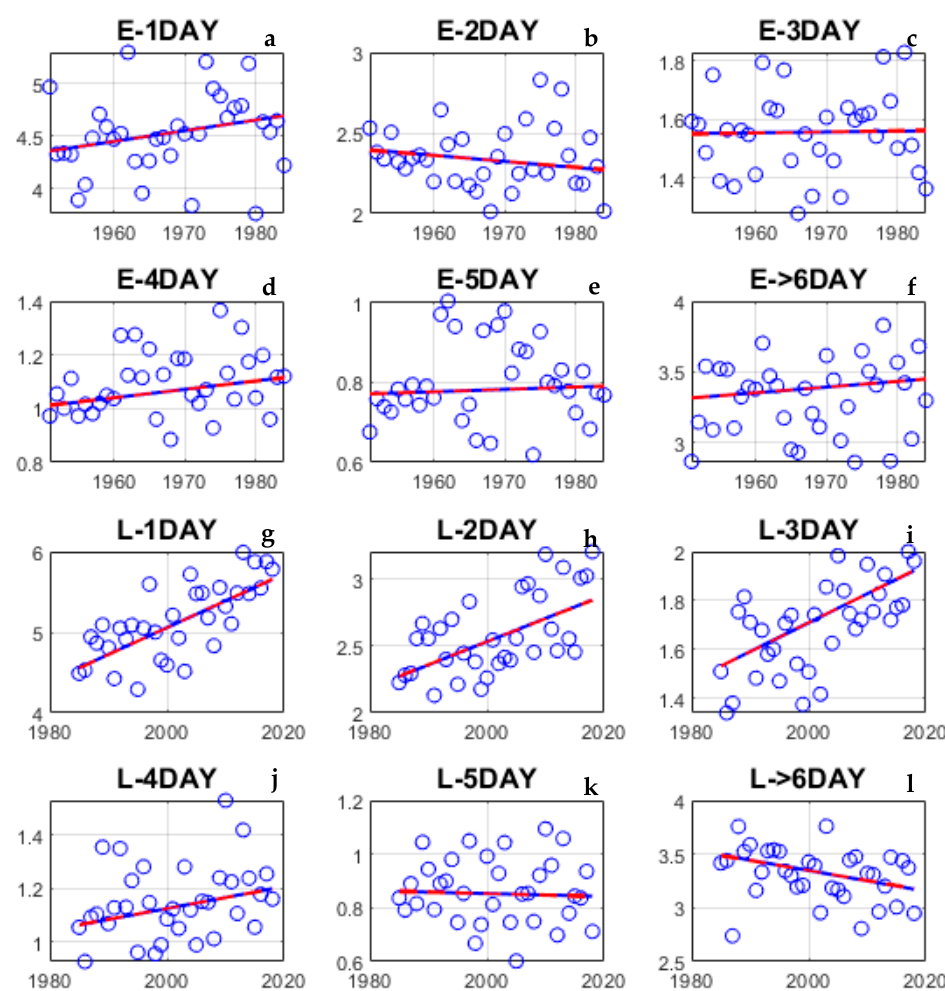
Figure 4. MK test for continuous rainfall events over India for 1 DAY to 5 DAY and more, ( a – f ) E-period, ( g – l ) L-Period. On each panel prefix, “E” means, data considered from 1951 to 1984, while prefix “L” means, data consideration from 1985 to 2018. Continuous rainfall of 1 day, 2 days, 3 days, 4 days and N days are referred as 1DAY, 2DAY, 3DAY and NDAY respectively. The blue line shows the trend, while the red dotted lines show confidence at a 95% significance level here.